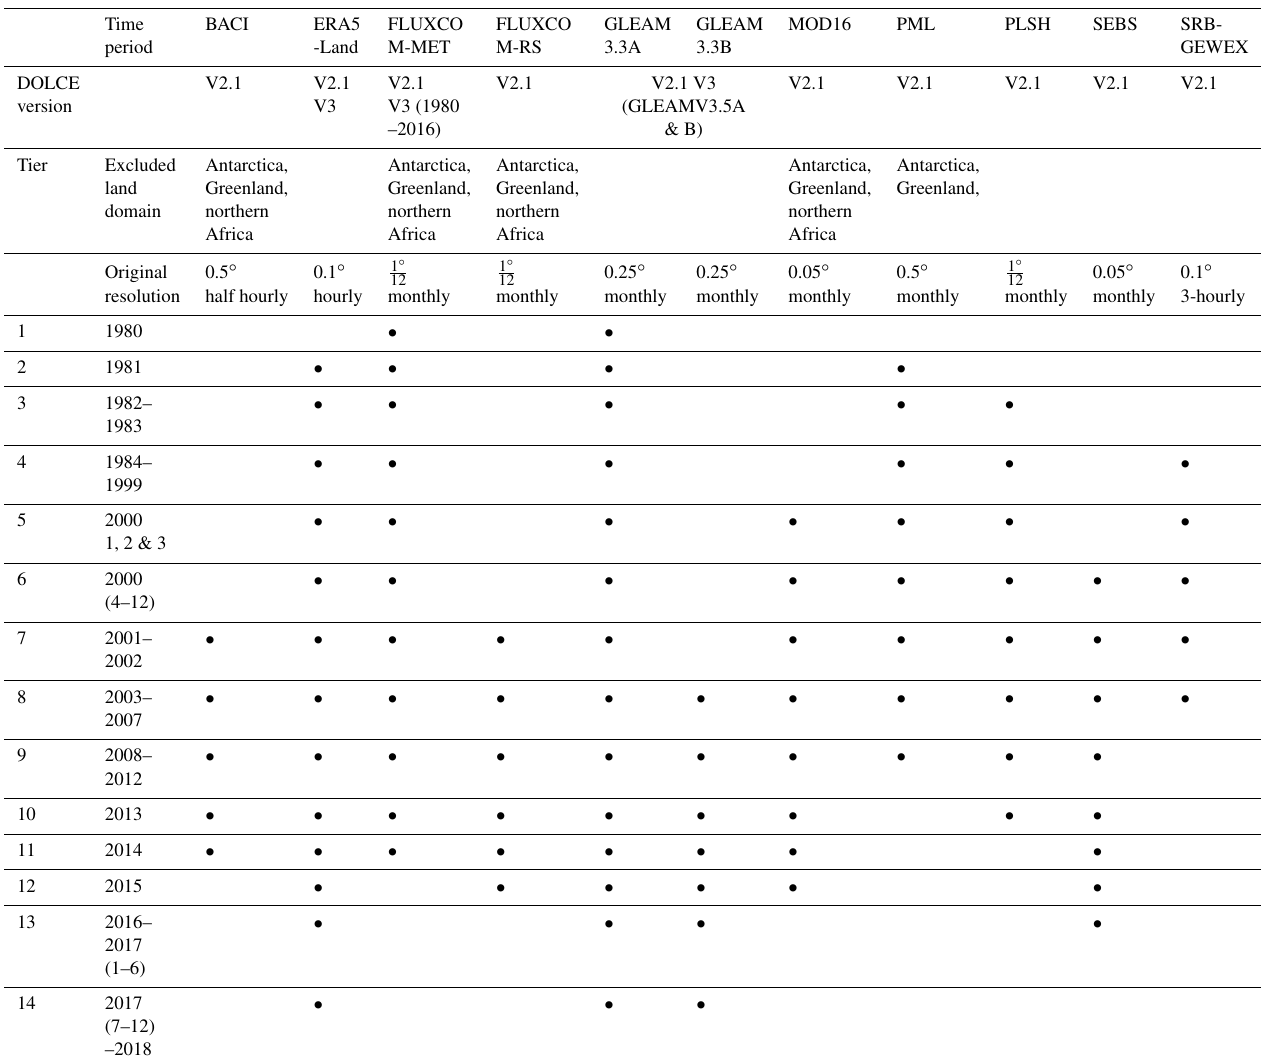
Table 1. Spatial and temporal coverage and original resolution of the global ET datasets (at the time of analysis) used to develop DOLCE V2.1 and DOLCE V3. DOLCE V2.1 was derived from 11 datasets and 14 temporal tiers. DOLCE V3 was derived from four datasets and four temporal tiers, i.e. (1) 1980, (2) 1981–2002, (3) 2003–2016, and (4)